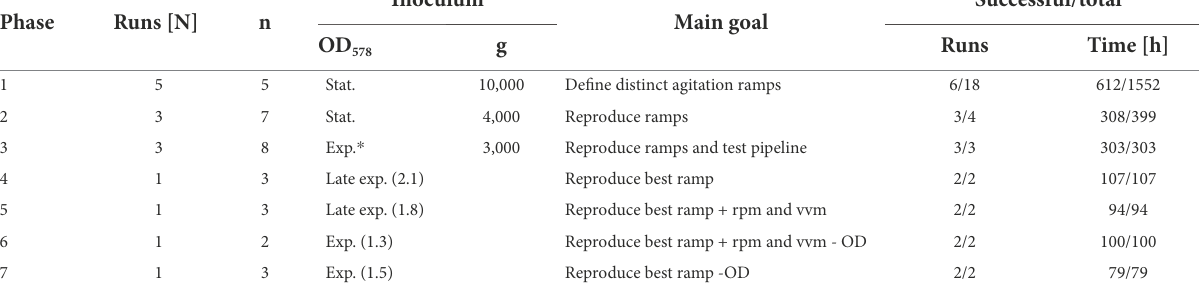
TABLE 2 Distinct experimental groups of 1.5 L reactor cultures ( Figure 3 ).